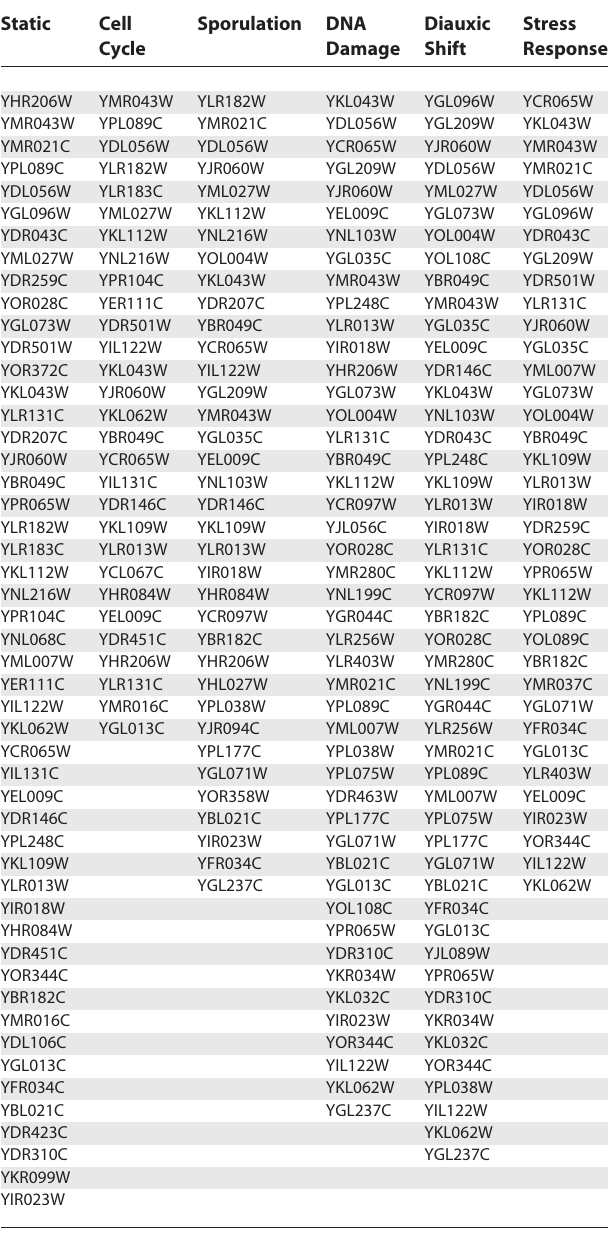
Table 1. The Transcriptional Hubs Included in This Study